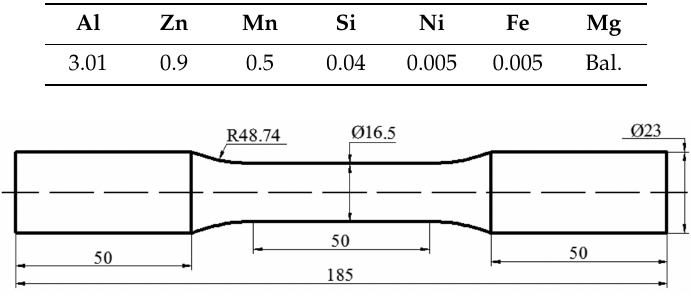
Table 1. Chemical composition of AZ31 magnesium alloy (mass fraction / %) .